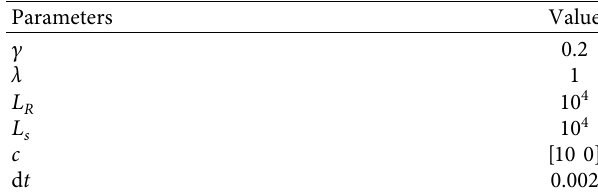
Table 7: System parameter values of a second-order DC motor [37].